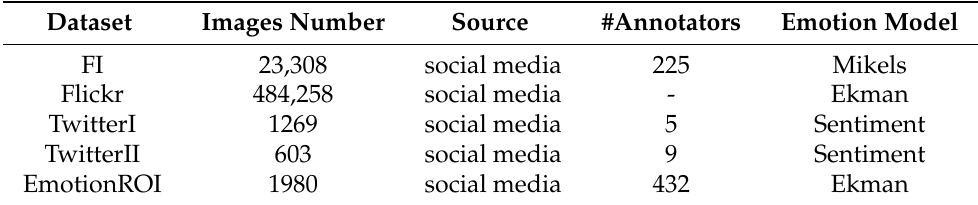
Table 1. Released and freely available datasets, where #Annotators respectively represent the number of annotators.